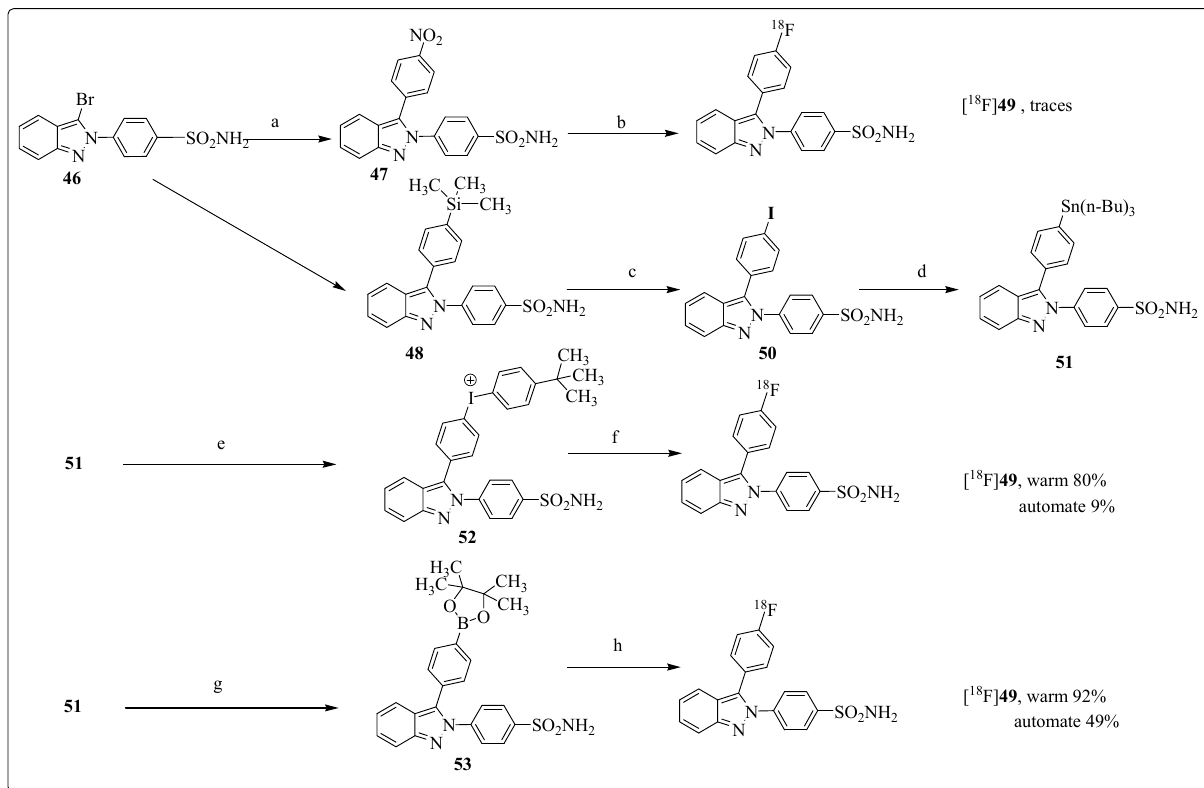
Figure 15. Reagents and conditions: (a) corresponding boronic acid (1.2 equiv), Cs 2 CO 3 (3.0 equiv), Pd(PPh3)4 (0.1 equiv), dioxane, 150 ◦ C, lW, 1 h, 42 53%, 25 69%; (b) [K/K 222 ] + 18 F − , DMF, 130 ◦ C, lW, 20 min; (c) ICl (2.0 equiv), CH 2 Cl 2 , 0 ◦ C then t.a., 1.5 h, 99%; (d) n-Bu 6 Sn 2 (3.3 equiv), Pd(PPh 3 ) 4 (0.1 equiv), dioxane, 90 ◦ C, 2 h, 33%; (e) Moser reagent (1.5 equiv), CH 3 CN/CH 2 Cl 2 (1/1), r.t., 18 h, 73%; (f) [K/K 222 ] + 18 F − , DMF, Cu(OTf) 2 cat, 100 ◦ C, lW, 10 min; (g) 1,4-bis(4,4,5,5-tetramethyl-1,3,2- dioxaborolan-2-yl)benzene (3.0 equiv), Na 2 CO 3 (6.5 equiv.), Pd(PPh 3 ) 4 (0.02 equiv), dioxane, 100 ◦ C, lW, 40 min, 52%; (h) KOTf; K 2 CO 3 , [ 18 F]KF, Cu(OTf) 2 cat., DMF, pyridine, 130 ◦ C, 20